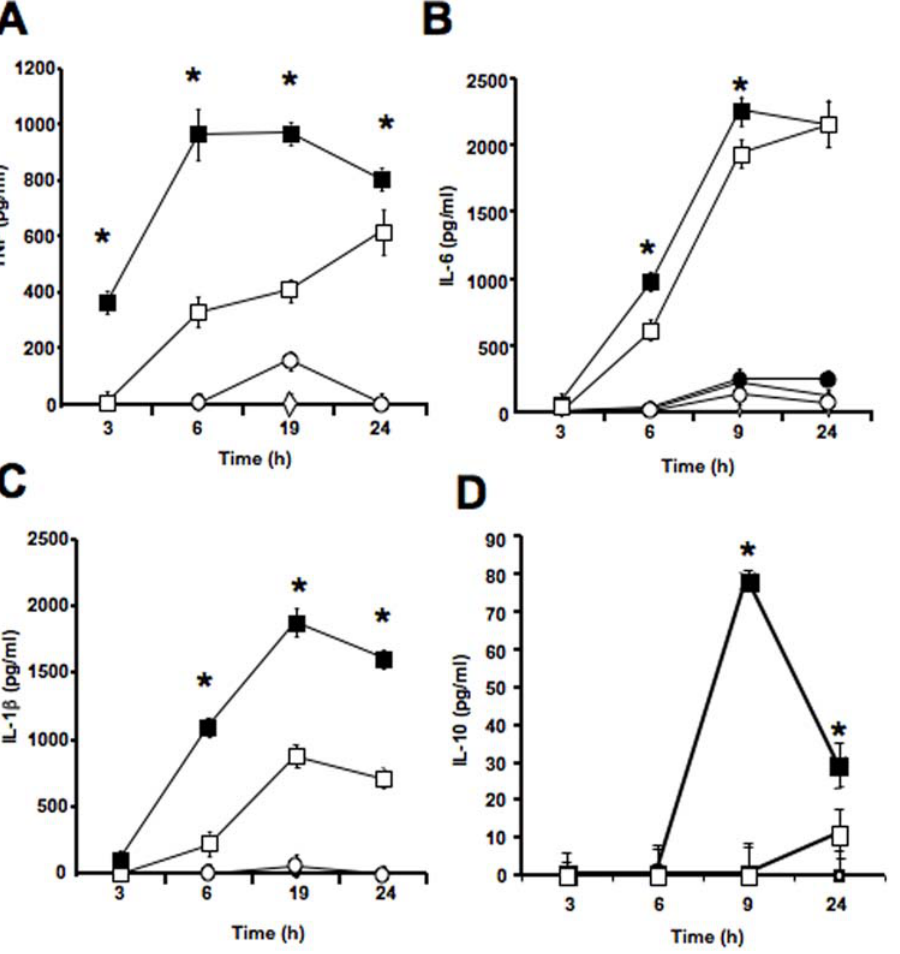
Figure 4. Time course of P.falciparum -induced TNF, IL-6 and IL-1 b release from PBMCs in the presence of allopurinol. PBMCs were incubated with mature P. falciparum infected erythrocytes (squares), uninfected erythrocytes (circles) or media alone (diamonds) at a ratio of (5:1; erythrocyte:PBMC) for the indicated time points in the presence (white symbols) or absence (black symbols) of 2 mM allopurinol. Incubation media were collected and TNF (A), IL-6 (B), IL-1 b (C) or IL-10 (D) concentrations were determined by ELISA. Data represent the average of triplicated samples with standard deviations. *, indicates significant differences ( p , 0.05) in cytokine release by PBMCs incubated with iRBCs when compared to IRBCs in the presence of allopurinol.